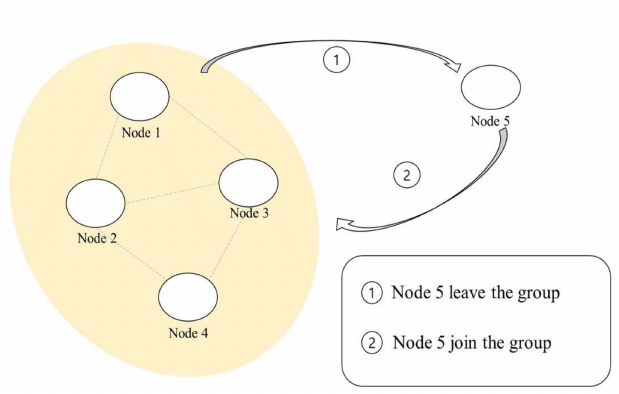
Figure 13. Network boundary.